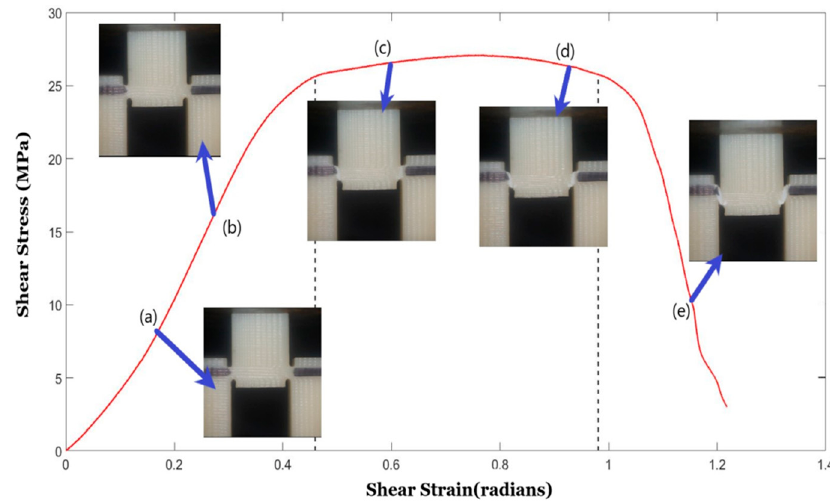
Figure 6. Example of the Shear zone in a vertical raster-oriented print provided with real time photos from video recording taken at each section in the graph. Sections are denoted by the corresponding letters of arrows; ( a , b ) represent the specimen undergoing small visually unnoticeable shear deformation, ( c , d ) represents the shear zone in which the specimen begins to deform significantly, and ( e ) represents the sliding of the sheared piece.